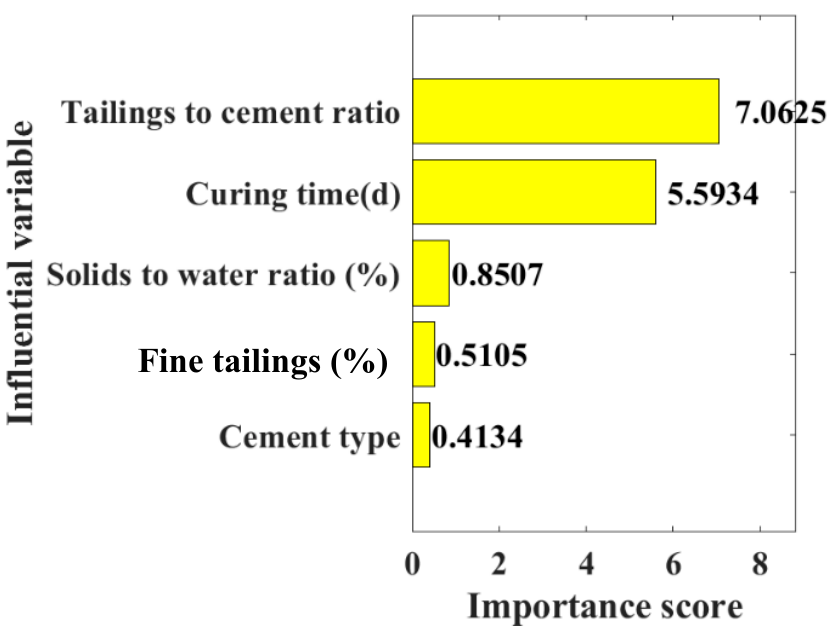
Figure 7. Variable importance of CPB.